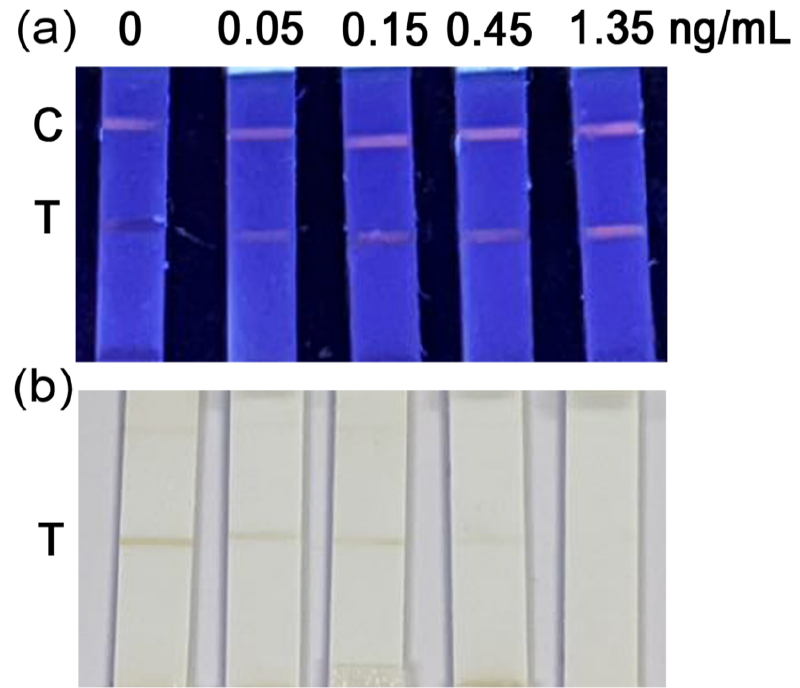
Figure 5. Detection of ENR using MnO 2 NSs-based fluorescent quenching immunosensors (FQISs). A series of concentrations of ENR (0, 0.05, 0.15, 0.45 and 1.35 ng/mL) was prepared in pH 7.4 HEPES (20 mM) and detected under ( a ) UV lamp and ( b ) natural light.